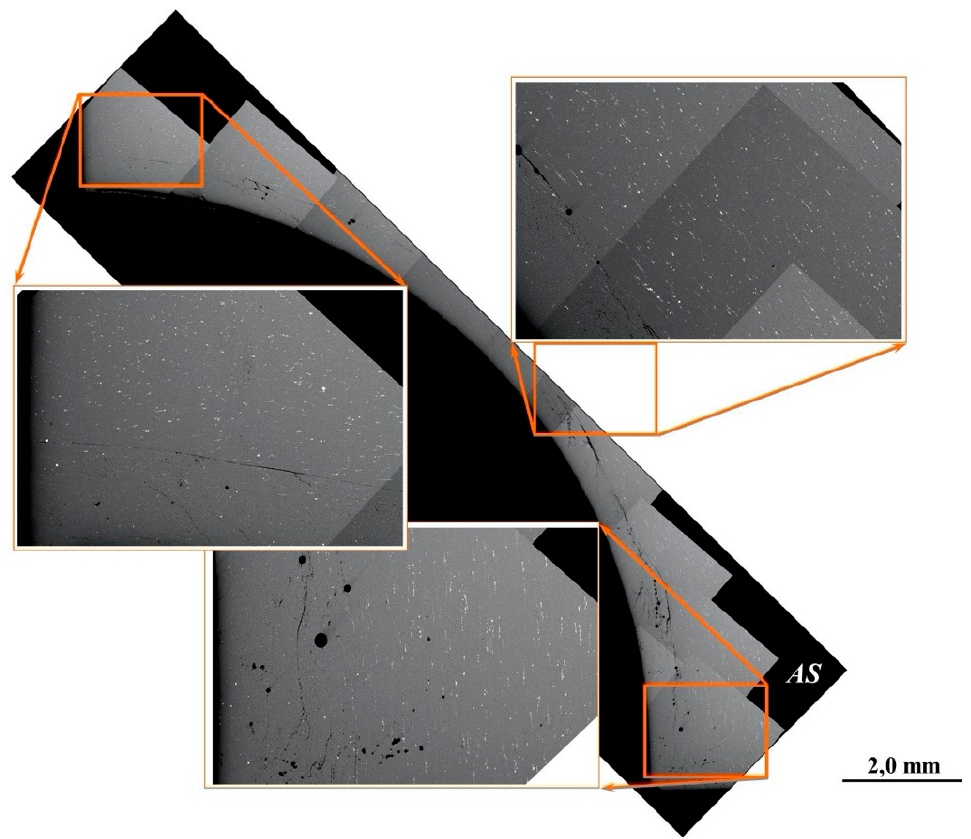
Figure 15. SEM BSE composite image of the metal and precipitates in the FSW tool exit hole leading edge metal (Section 2.2 in Figure 2).